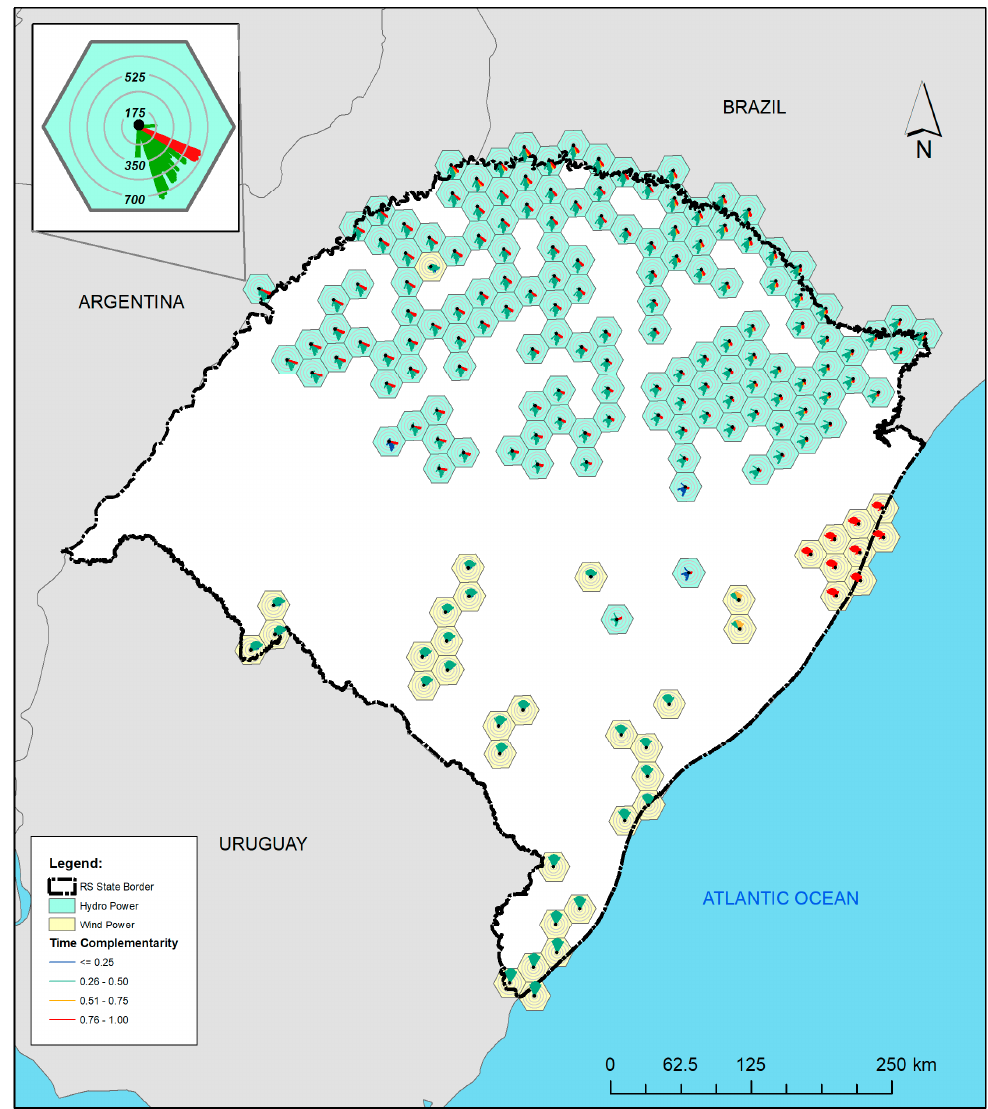
Figure 8. Maps of the State of Rio Grande do Sul with roses of complementarity indicating the spatial complementarity in the time between the plants marked in Figure 7.